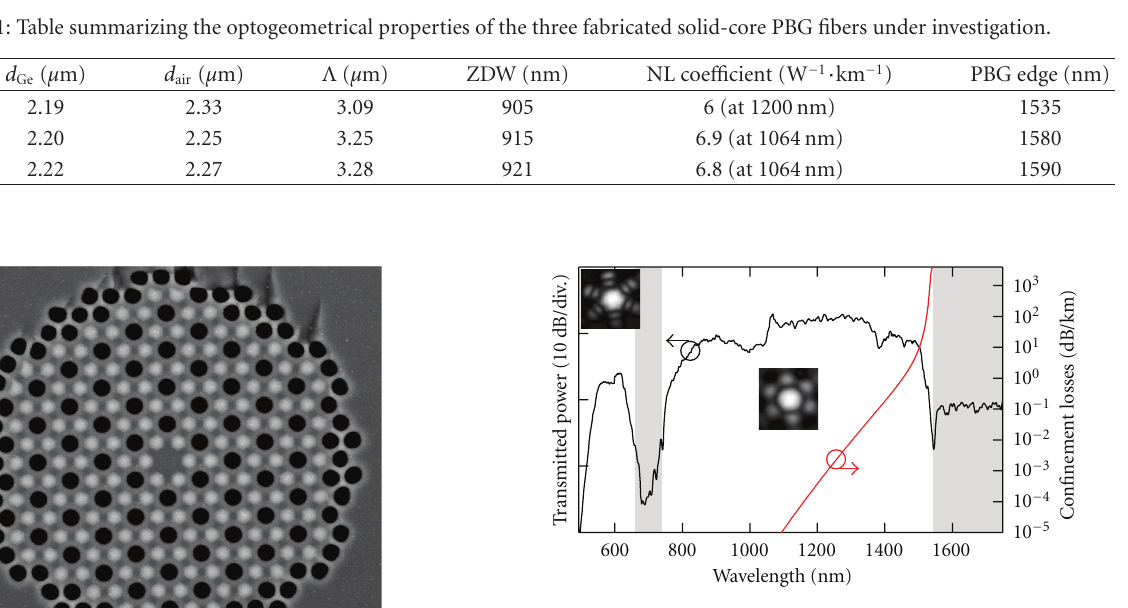
Figure 2: Transmission spectrum of the solid-core PBG fiber 1 (black line, left axis) measured with a SC source, and computed confinement losses across the first PBG (red line, right axis). Insets show the near-field mode profile in the first (right) and second (left) PBG. Gray areas depict spectral regions in which the PBG guidance in the core is not allowed.